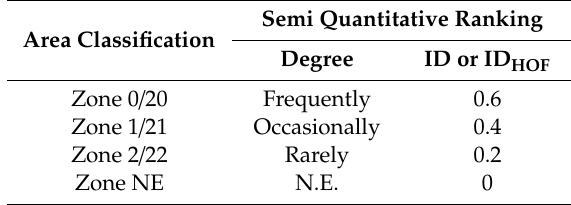
Table 10. The semi-quantitative ranking system for the ATEX-HOF risk evaluation.